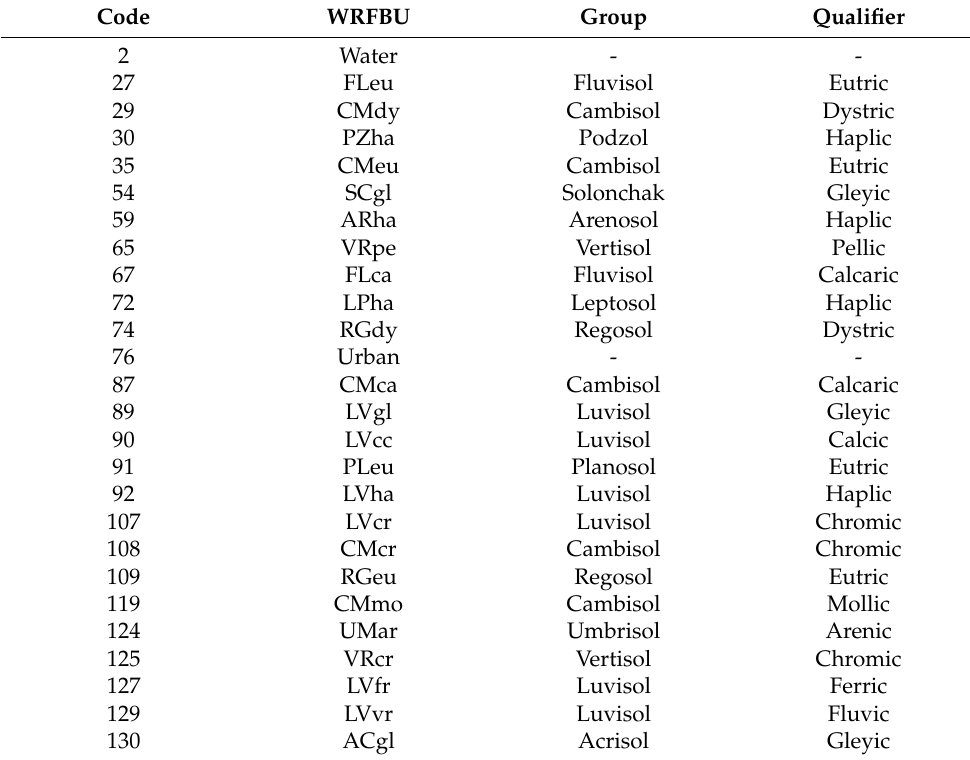
Table A1. Soil codes and legend from the international soil classification system.